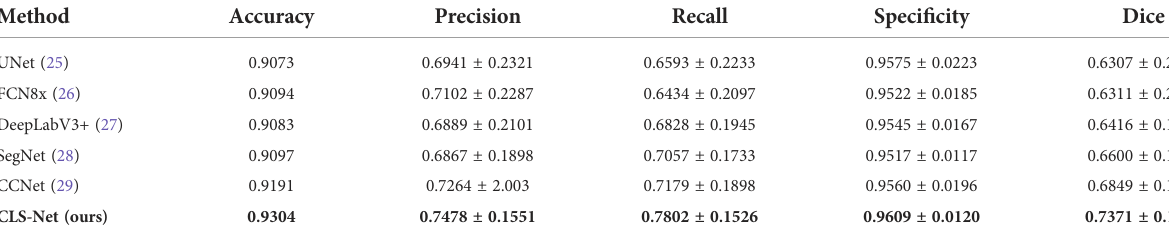
TABLE 2 The metrics of CLS-Net and the state-of-art methods in our dataset.